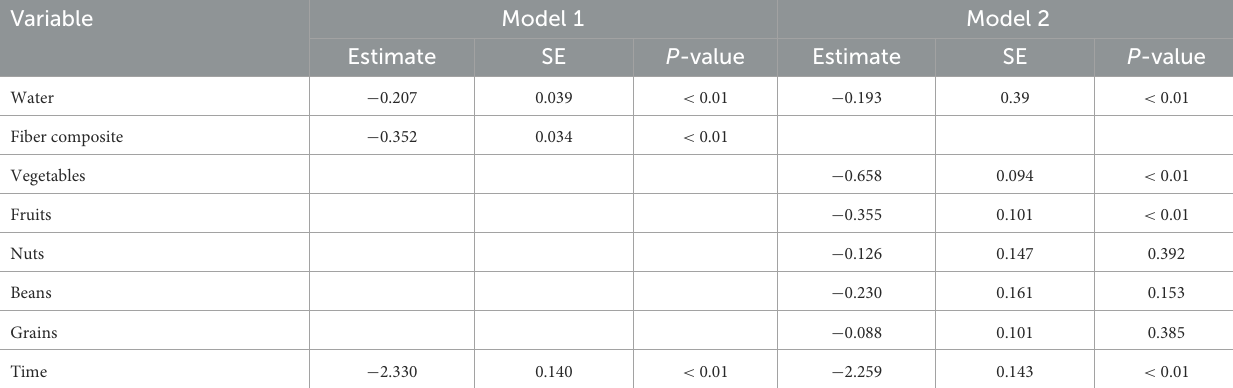
TABLE 3 Within-subject associations between intake of fiber-rich food composition, individuals’ fiber-rich food categories, and body weight.